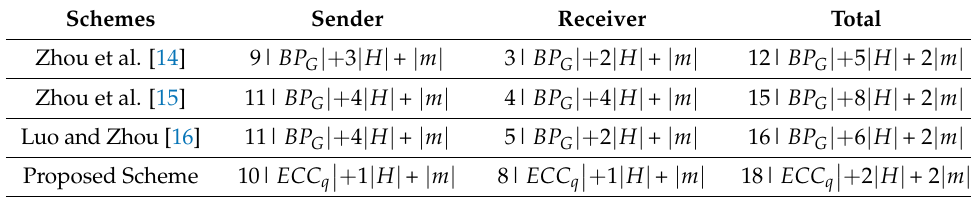
Table 5. Memory Overhead Analysis.